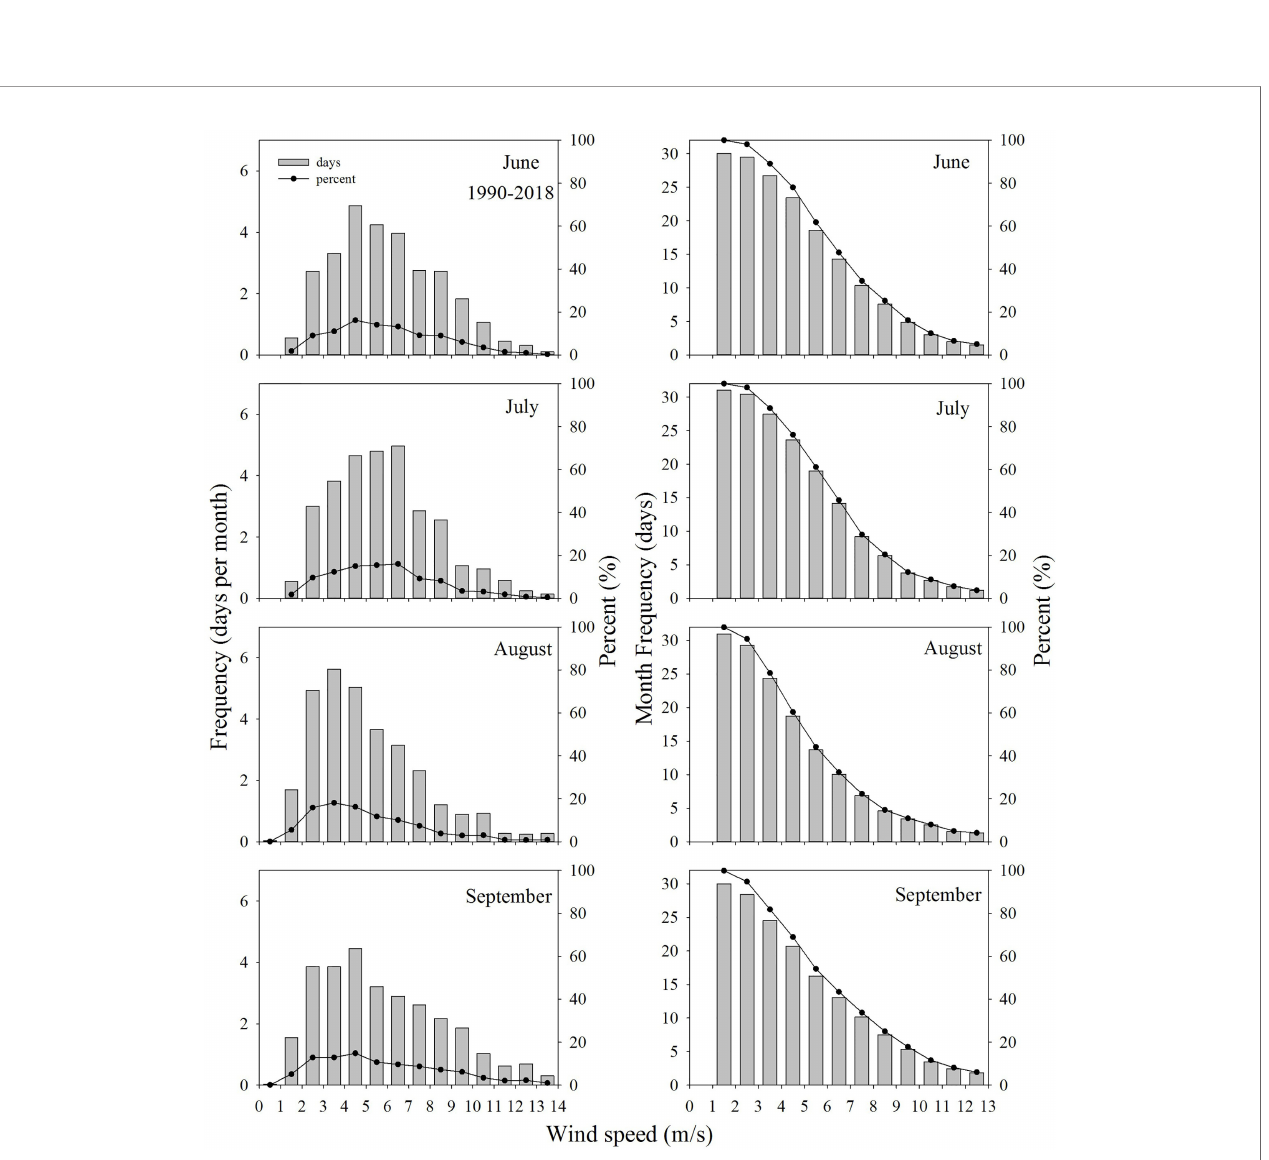
FIGURE 7 | The frequency of grouped wind speeds during 1990-2018 in summer (left panel) and accumulative frequency of grouped wind speeds (accumulated from the largest wind speed group to the smallest one) (right